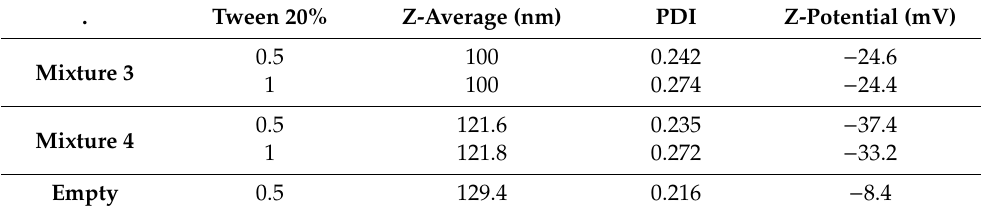
Table 2. Results of dynamic light scattering (DLS) and Z-Potential